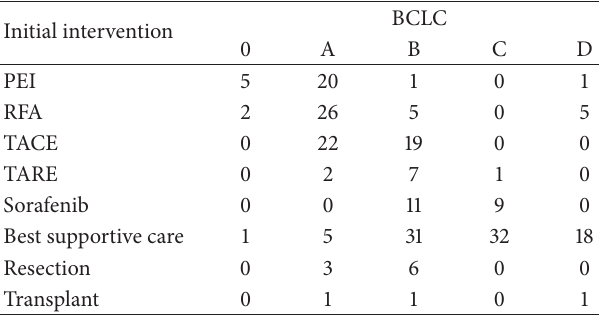
Table 5: Initial intervention modalities per BCLC tumor